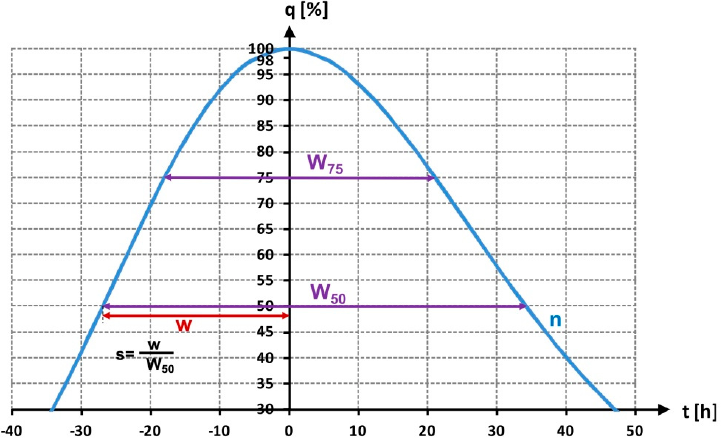
Figure 2. Exemplary parametric design flood hydrograph. W 50 -hydrograph width at 50% of the peak flow; W 75 -hydrograph width at 75% of the peak flow; s -skewness coefficient; n -shape